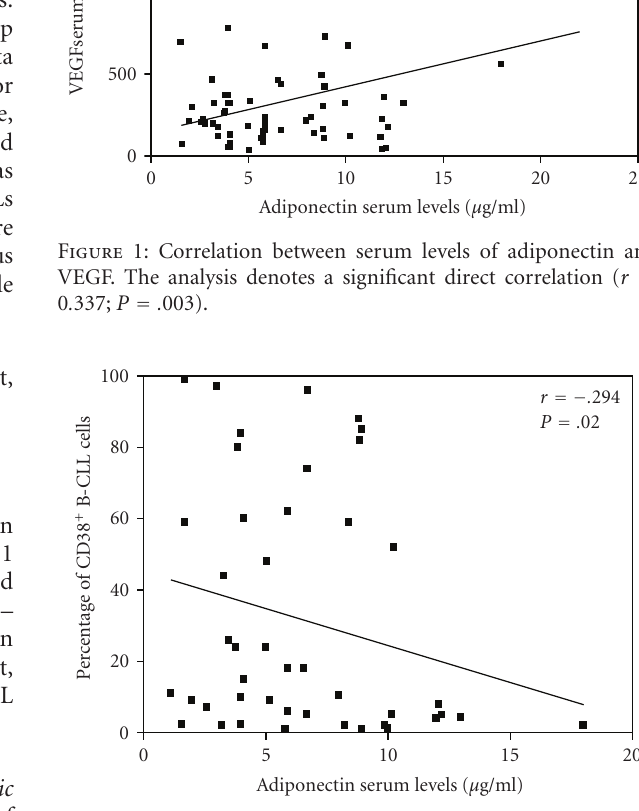
Figure 2: Correlation between serum levels of adiponectin and percentage of CD38-positive B-CLL cells. The analysis denotes a significant inverse correlation ( r = − 0 . 294; P = .